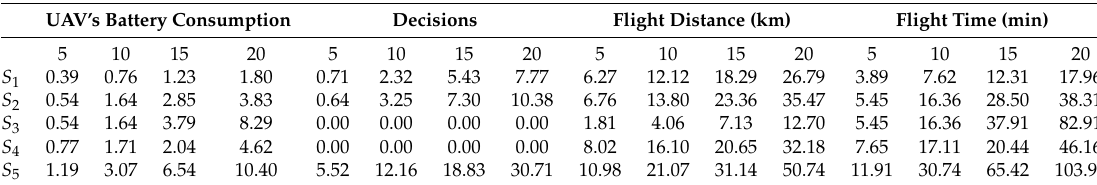
Table 3. Descriptive results obtained on simulations.